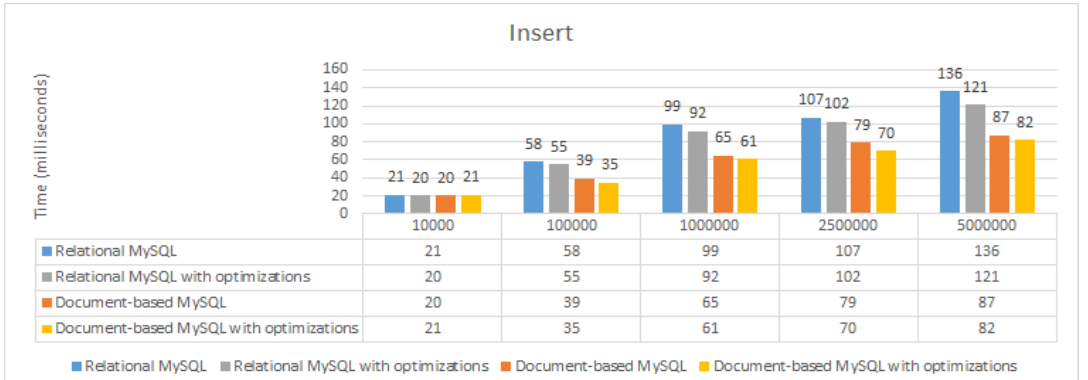
Figure 3. Performance time (ms) for the insert operation.